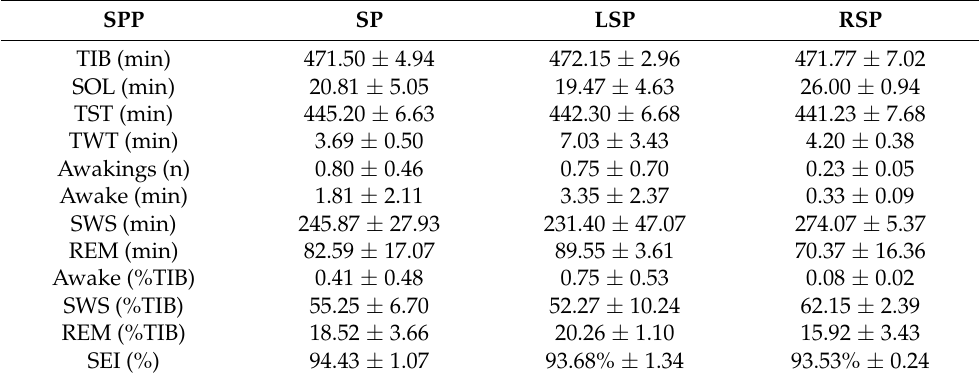
Table 2. Subjects’ objective sleep